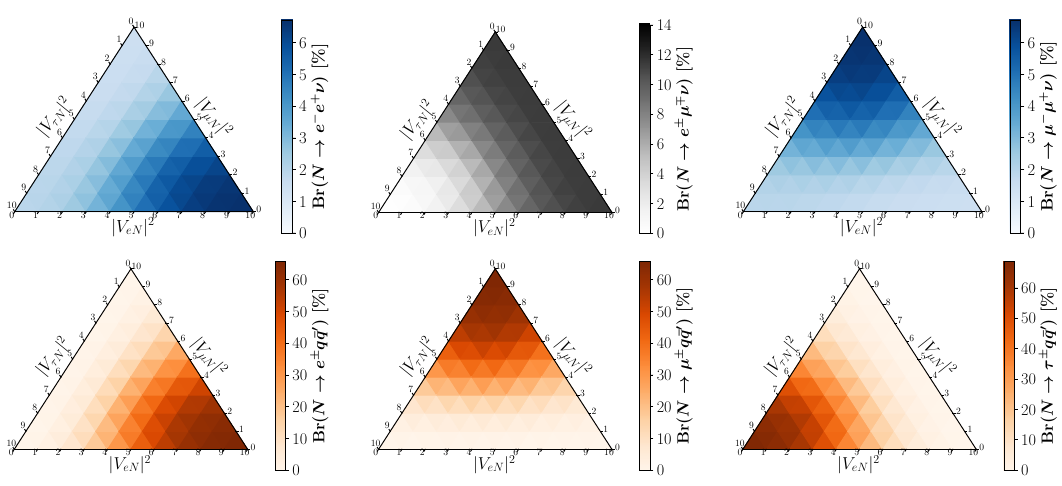
Figure 3 . Branching ratios for di(cid:11)erent decay channels for m N = 10 GeV as a function of 2 : 2 : 2 , since the absolute size of V eN V (cid:22)N V (cid:28)N j j j j j j di(cid:11)erent scales chosen to better illustrate the impact of each